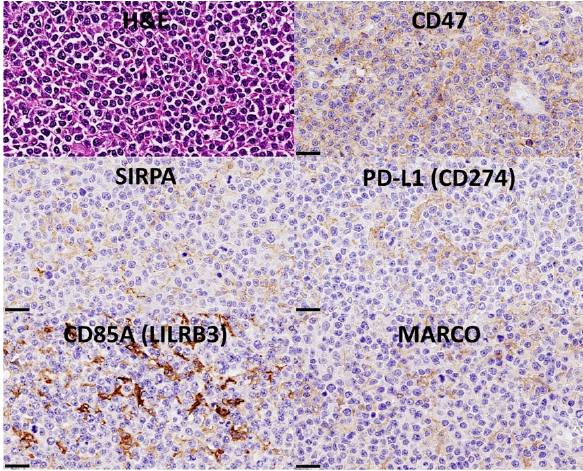
Figure 17. Correlation between expression levels of CSF1R and SIRPA/CD47 in diffuse large B-cell lymphoma. The immunohistochemical pattern of CSF1R-positive tumor-associated macrophages (TAMs) suggested a relationship with other makers such as SIRPA. SIRPA is a relevant immune checkpoint marker that mediates negative regulation of phagocytosis. The histological pattern of SIRPA was of TAMs, similar to PD-L1, CD85A, and MARCO. A ligand for SIRPA is CD47. In our series, the histological pattern of CD47 was of B lymphocytes of the diffuse large B-cell lymphoma.